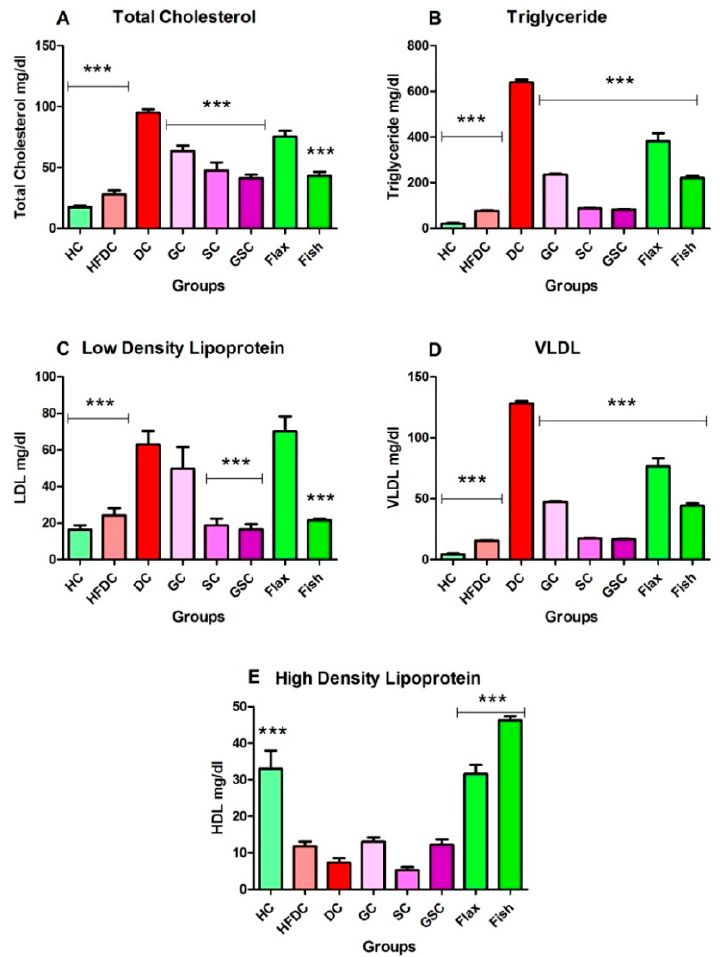
Figure 5. Assessment of lipid profile from experimental groups. Results are represented as Mean ± SE (n = 6 for each group). *** p ≤ 0.001, when compared with the DC group (Dunnett’s Multiple Comparisons Test). ( A ) Serum total cholesterol level, ( B ) Serum triglycerides level, ( C )